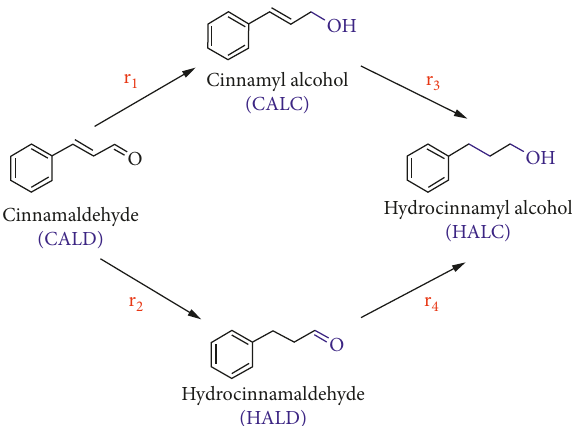
Figure 1: Reaction scheme of cinnamaldehyde